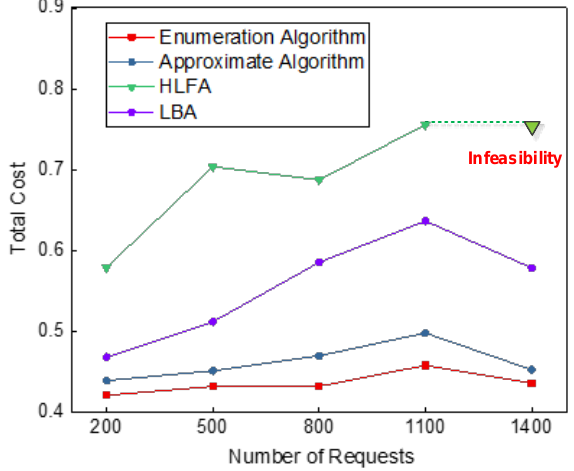
Figure 6. Comparisons of total cost under different number of requests, when η 1 = 0.6.